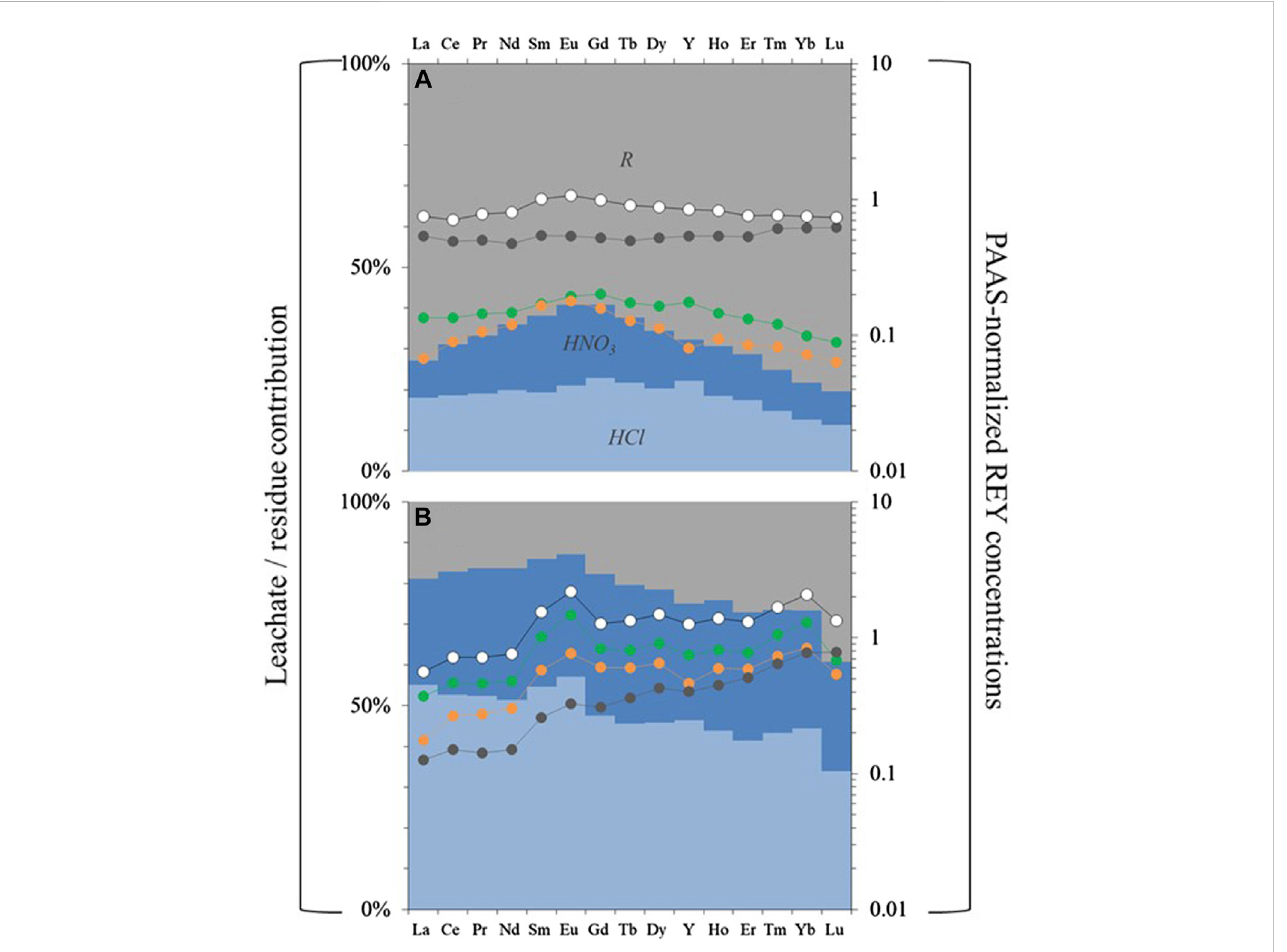
FIGURE 5 ContributionofleachatesL3andL4(bluevertical bars)andresidualR(greyverticalbars)fractionsandrelatedPAAS-normalizedREYpatterns(lines)in (A) the Group I (at JOSAN) and (B) Group IV (at JOEP). White circles correspond to the bulk sample before leaching whereas the green, the orange and the dark grey represent the 1N HCl (L3), 2N HNO 3 (L4) and residual (R) fractions, respectively.